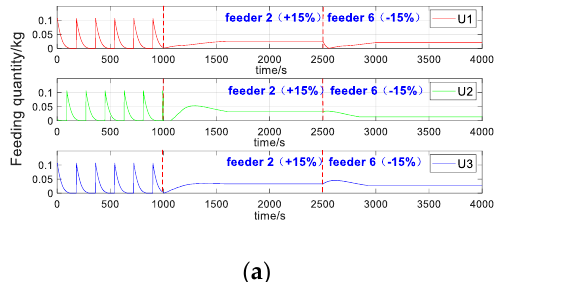
Figure 11. Distributed feeding quantity control: ( a ) subsystems 1 – 3; ( b ) subsystems 4 – 6.